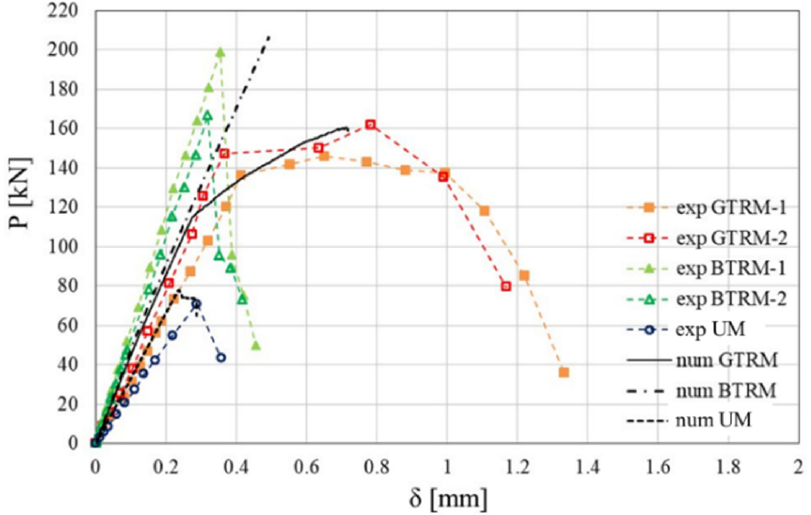
Figure 13. Comparison of experimental and numerical results: vertical load vs vertical displacement. The experimental and numerical trends are in fairly good agreement, despite the absence of a post-peak softening phase for the GTRM and BTRM numerical curves. In particular, the numerical model is able to catch the two-fold trend of GTRM experimental curves, characterised by the knee point (P k and δ k ) and also observed in [15]. The BTRM numerical curve (“num BTRM” in Figure 13) was obtained by assuming that no damage occurs in the bed and head interface joints (Figure 9a). Indeed, it was found that the numerical model omitted to reproduce the BTRM damage behaviour, showing an absence of bed joint sliding. With the assumption of neglecting bed and head joint sliding, the numerical BTRM linear elastic trend shown in Figure 13 predicts the experimental curve more accurately. Table 13 summarises the numerical results in terms of peak loads, peak displacements, relative average values and failure modes, providing a comparison with the corresponding experimental values. Table 13. Numerical results (peak load, peak displacement, failure mode) and comparison with the experimental